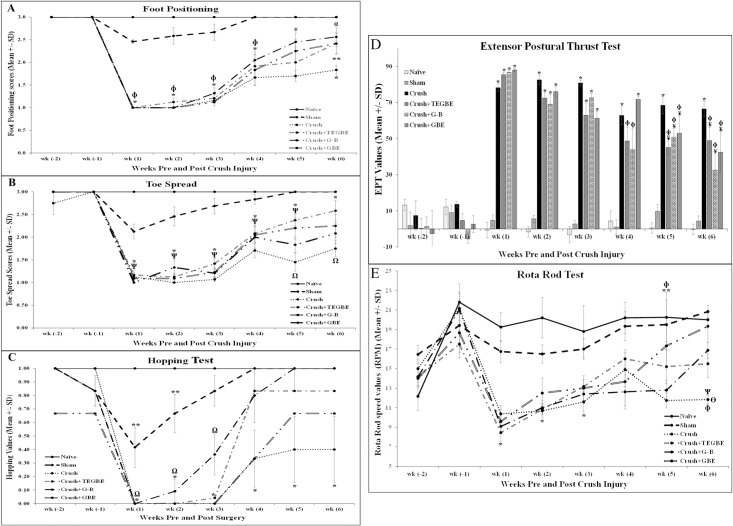
Neurobehavioral assessments.A: Analysis of foot position showed statistically (P< 0.05) faster and progressive recovery in TEGBE (n = 12), G-B (n = 12) and GBE-treated (n = 6) groups starting at week 4 compared to crush group. * indicates P<0.0001, crush vs. sham and naive groups. ɸ indicates P<0.002, treated groups with TEGBE, G-B and GBE vs. sham and naive groups. α indicates P<0.03, TEGBE, G-B and GBE treated groups vs. crush group. ** indicates P<0.05, TEGBE and GBE-treated groups vs. naive and sham groups. B: Analysis of toe spread outcome. The TEGBE, G-B and GBE-treated animals showed both clinically and statistically significant recovery in toe spread following sciatic nerve injury from week 1 till week 6 post-injury. By week 6, toe spread analysis revealed significant (p< 0.05) recovery in TEGBE-treated animals compared to crush group and is a noticeable increase in toe spread recovery of the other treated groups (G-B and GBE) toward normal values. * indicates p<0.0001, crush vs. sham and naive groups. Ω indicates P<0.003, TEGBE treated group vs. crush group. Ѱ indicates P<0.003, TEGBE, G-B and GBE treated groups vs. sham and naive groups. C: Differences in the mean values of the hopping test outcome among the experimental animal groups. The TEGBE and G-B-treated groups showed a significant improvement in the hopping behavior starting from week 4 until the end of the experiment compared to crush group. Further, the TEGBE and G-B-treated groups displayed an early hopping response ((as calculated by the percentage of recovered animals) at week 3 while the G-B rats started to improve by week 5. * indicates P<0.05, crush vs. sham and naive groups. ** indicates P<0.05, sham group vs. naive group. Ω indicates P<0.0001, all treated groups vs. sham and naive groups. D: Evaluation of functional recovery as measured by extensor postural thrust (EPT) following crush injury and TEGBE, G-B and GBE treatments. G-B-treated animals showed approximately 50% motor recovery compared to crush at week 6, indicating faster recovery. However, the G-B-treated group was not significantly recovered compared to the naive group. * indicates P<0.0001, treated groups (TEGBE, G-B, and GBE) and crush group vs. sham and naive groups. ɸ indicates P<0.05, treated groups with TEGBE, G-B and GBE vs. naive and sham. ¥ indicates P<0.05, groups treated with TEGBE, G-B and GBE vs. crush group. E: Motor coordination analysis is shown based on rotarod speed values following crush injury and TEGBE, G-B and GBE treatments. Rotarod performance was measured using the Rotarod test set at the acceleration mode (initial speed starts from 5 rpm/min; while maximum speed set at 45 rpm/min). The Rotarod time latency that the animal falls is indicated on the Y-axis. Pre-surgery week 2 showed less speed due to initial training and adaptation. All treated groups showed significant improvement in Rotarod performance at week 6 post-injury compared with crush group. Sham animals showed better motor coordination compared to crush and treated animals from day 1. GBE-treated animals retain their motor coordination faster than G-B and TEGBE-treated animals. However, there is no significance between treated groups by the end of week 6. * indicates p<0.05, all treated groups with TEGBE, G-B and GBE as well as crush group vs. sham and naive. ** indicates p<0.02, G-B-treated group and crush group vs. naive group. Ѱ indicates p<0.005 crush group vs. sham and naive groups. ϕ indicates p<0.05 GBE group vs. crush group. ϴ indicates p<0.05, TEGBE and G-B -treated groups vs. crush group. Values are expressed as means ± SDs.